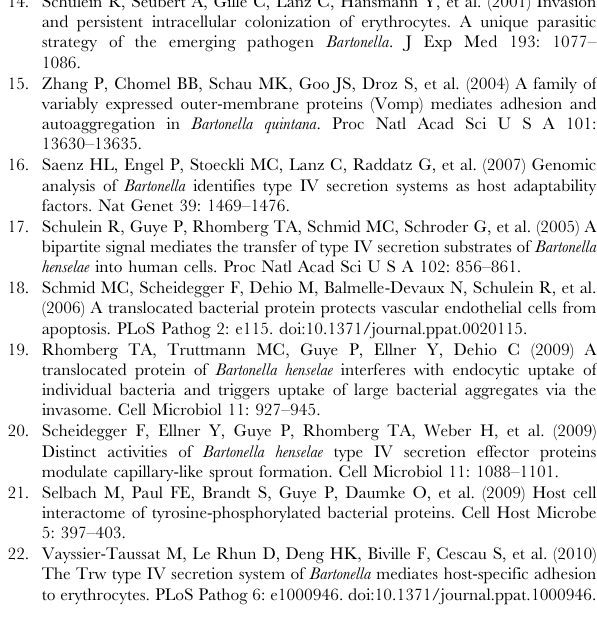
Figure S5 Domain structure of Bartonella effector proteins. Domain structure for (A) lineage 3 and (B) lineage 4. FIC and BID domains are shown in orange and violet, respectively. The FIC motif (HPFxxGNG) is depicted. Motifs differing from this consensus sequence are indicated. Beps are grouped according to the monophyletic clades indicated in Figure 4 (Bep clades). BARCL_0629 and BARCL_0635 are excluded from groups, because their phylogenetic positions are not well supported in the inferred gene trees (Figure 4 and Figure S6). Tandem-repeated tyrosine-phosphorylation motifs depicted for Bep clade 9, BepD, BepE, BepF, and BepH clade (green bars) were identified with the program NetPhos2.0 [52] using a threshold of 0.8. For other bep genes, no tandem-repeated motifs were identified. bep genes from different species of lineage 3 are only indicated by their locus_tags (BARCL_, Bc , BARRO_, Br , B11C_, B 1-1C, BAR15_, B AR15). Found at: doi:10.1371/journal.pgen.1001296.s005 (0.37 MB PDF) Figure S6 Bartonella effector protein gene trees based on (A) the FIC domain containing N-terminus or (B) the entire sequence of effector genes harboring an N-terminal FIC and C-terminal BID domain. The topology and branch lengths are according to maximum likelihood analysis. Numbers above the branches represent maximum likelihood bootstraps obtained with PAUP* [61]; numbers below the branches represent posterior probabilities obtained with MrBayes [62]. Values $ 80% are shown. Locus_tags and gene names (if existing) are given. beps are color-coded according to the species. The clustering of bep genes from lineage 3 and 4 is indicated by blue and green shading, respectively. Bold type highlights phylogenetic branches with d n/ d s values . 1 (the estimated d n/ d s value is indicated in red color type). Table S1 Estimates of average evolutionary divergence over sequence pairs within lineages (shaded in gray) and between lineages. Table S2 Genes of lineage 3 with average d n/ d s values ( v ) $ 0.25 and/or site-specific positive selection detected by CodeML (model M2a versus model M1a). Genes are ordered according to